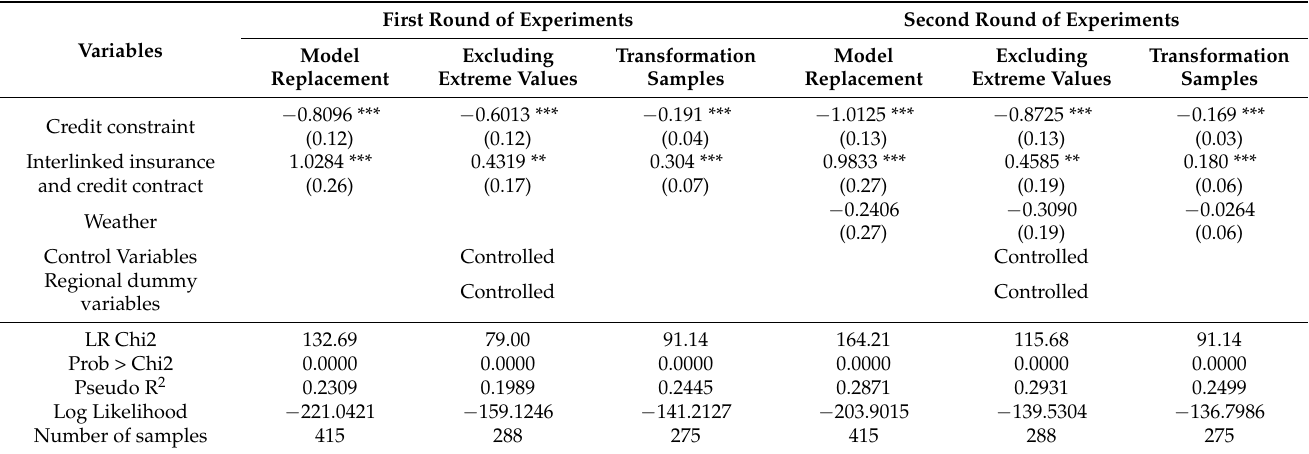
Table 7. Analysis of the moderating effects of interlinked insurance and credit